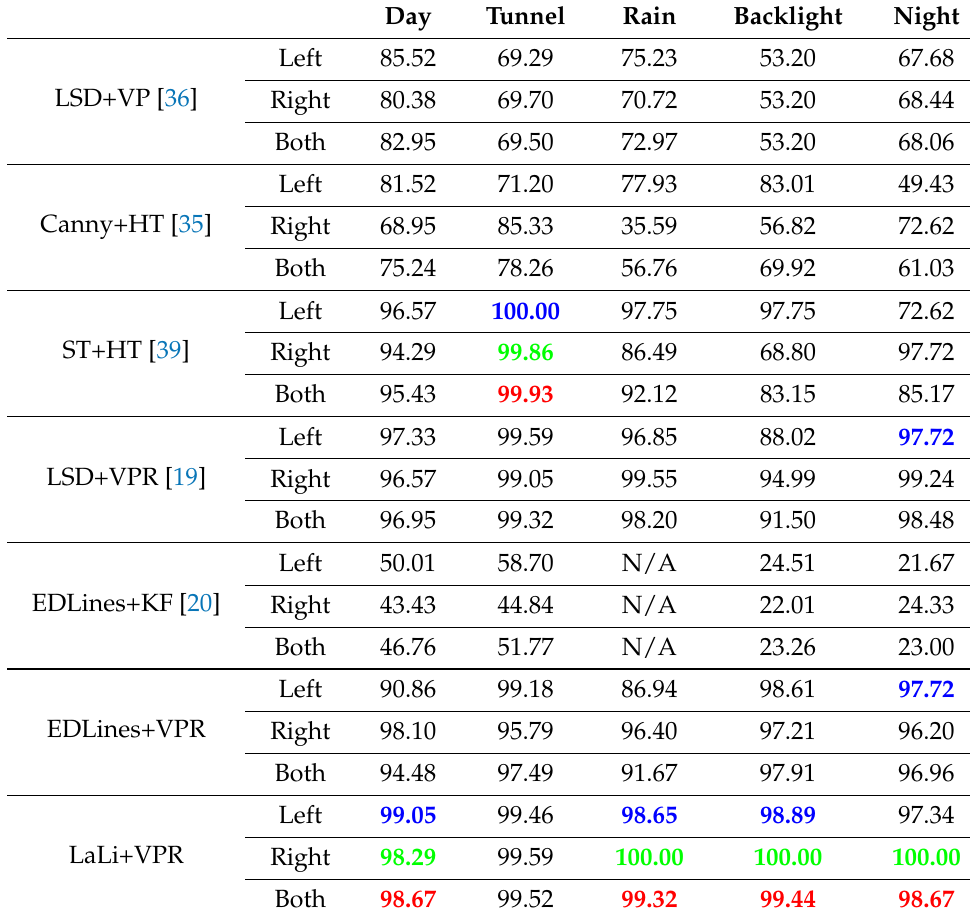
Table 2. Lane detection accuracies on KIST dataset